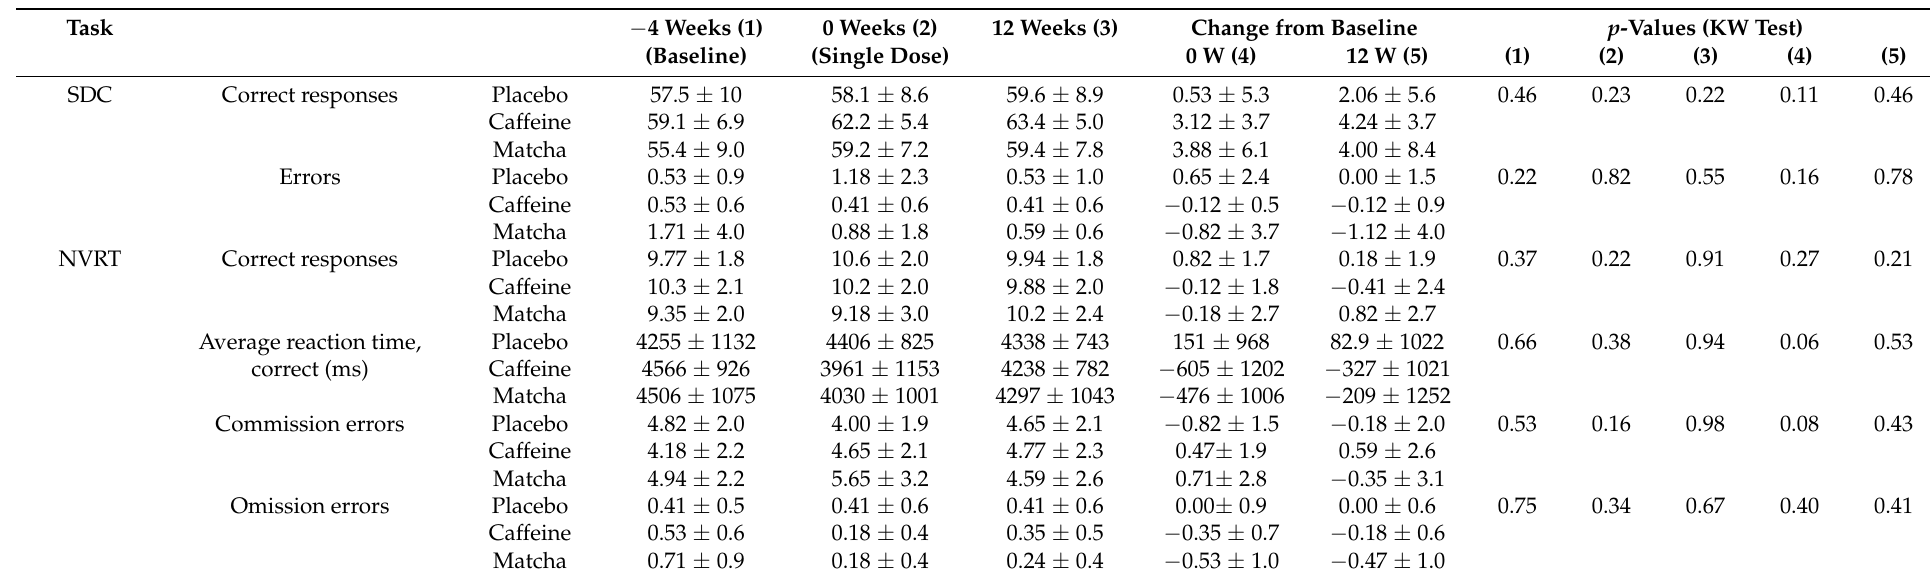
Table 8. Effect of matcha or caffeine intake on visual information processing-related tasks.